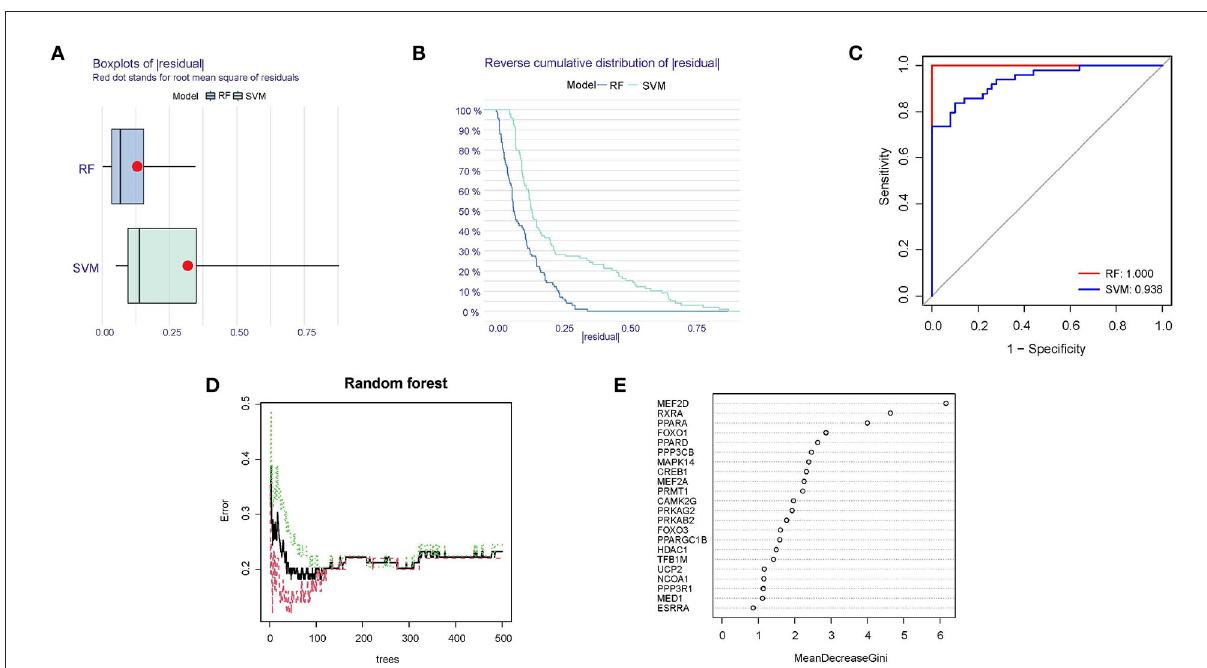
FIGURE5 Identification of diagnostic biomarkers using RF and SVM model. (A) Boxplots of the residuals of the sample. Red dot stands for root mean square of residuals. (B) Cumulative residual distribution map of the sample. (C) AUC verification results of the two models on the training dataset. (D) The influence of the number of decision trees on the error rate. (E) Results of the Gini coefficient method in the random forest